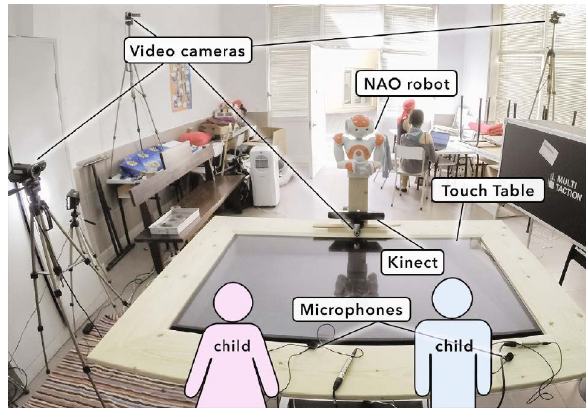
Figure 10: Example of layered modality from